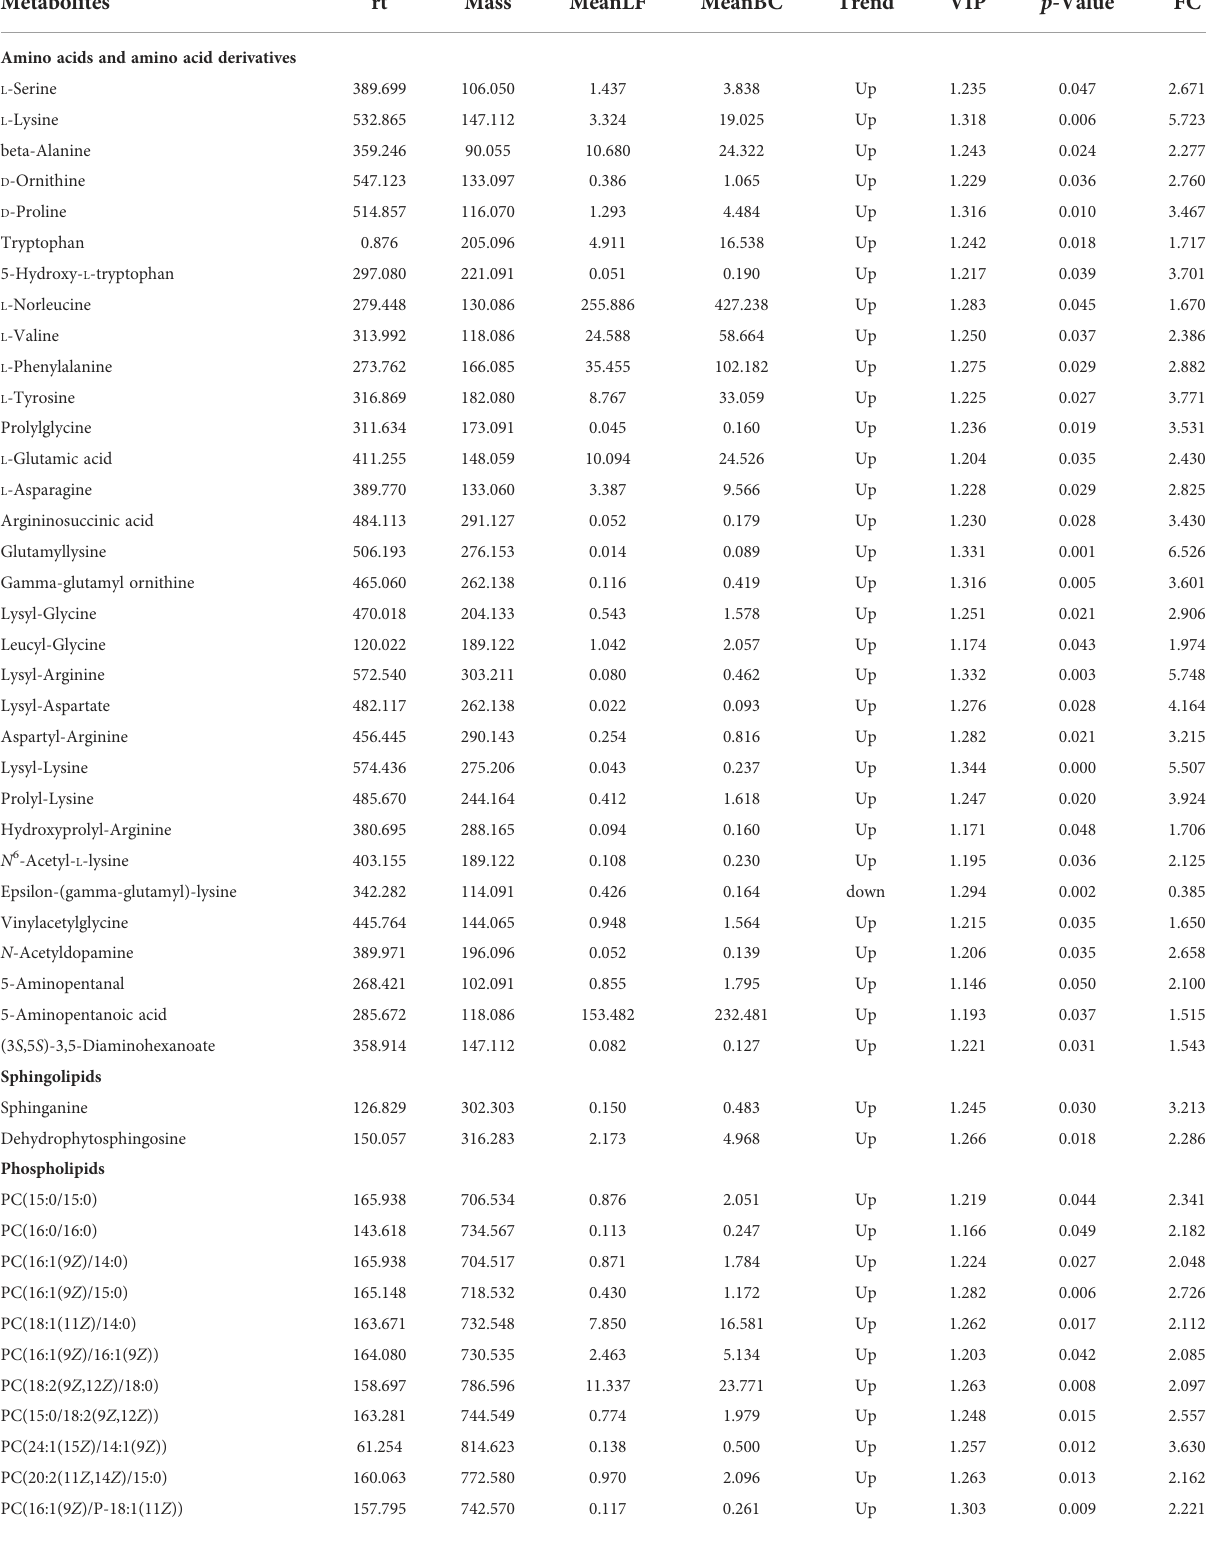
TABLE 4 The differential metabolites in fecal between LF and BC groups. Metabolites rt Mass MeanLF MeanBC Trend VIP